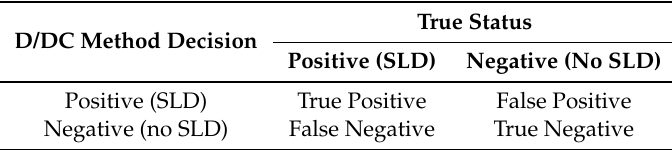
Table 2. Example of a classification table needed for utility